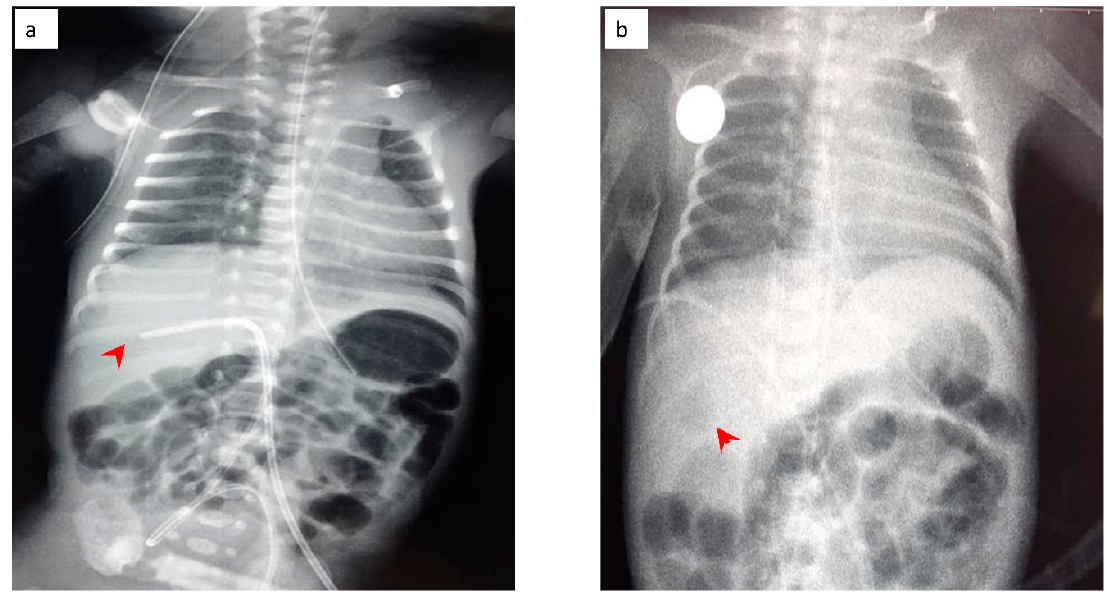
Figure 9. ( a ) Chest and abdominal radiography depicting the abnormal position of umbilical venous catheter in the liver (red arrowhead); and ( b ) chest and abdominal radiography depicting air in the branches of right portal vein and hepatic parenchyma (red arrowhead).